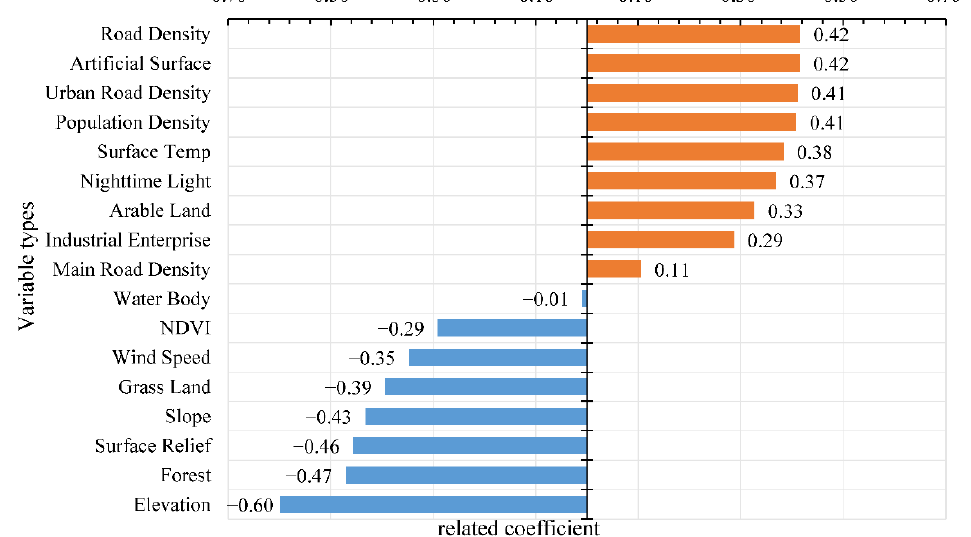
Figure 8. Influencing factors of air pollution.